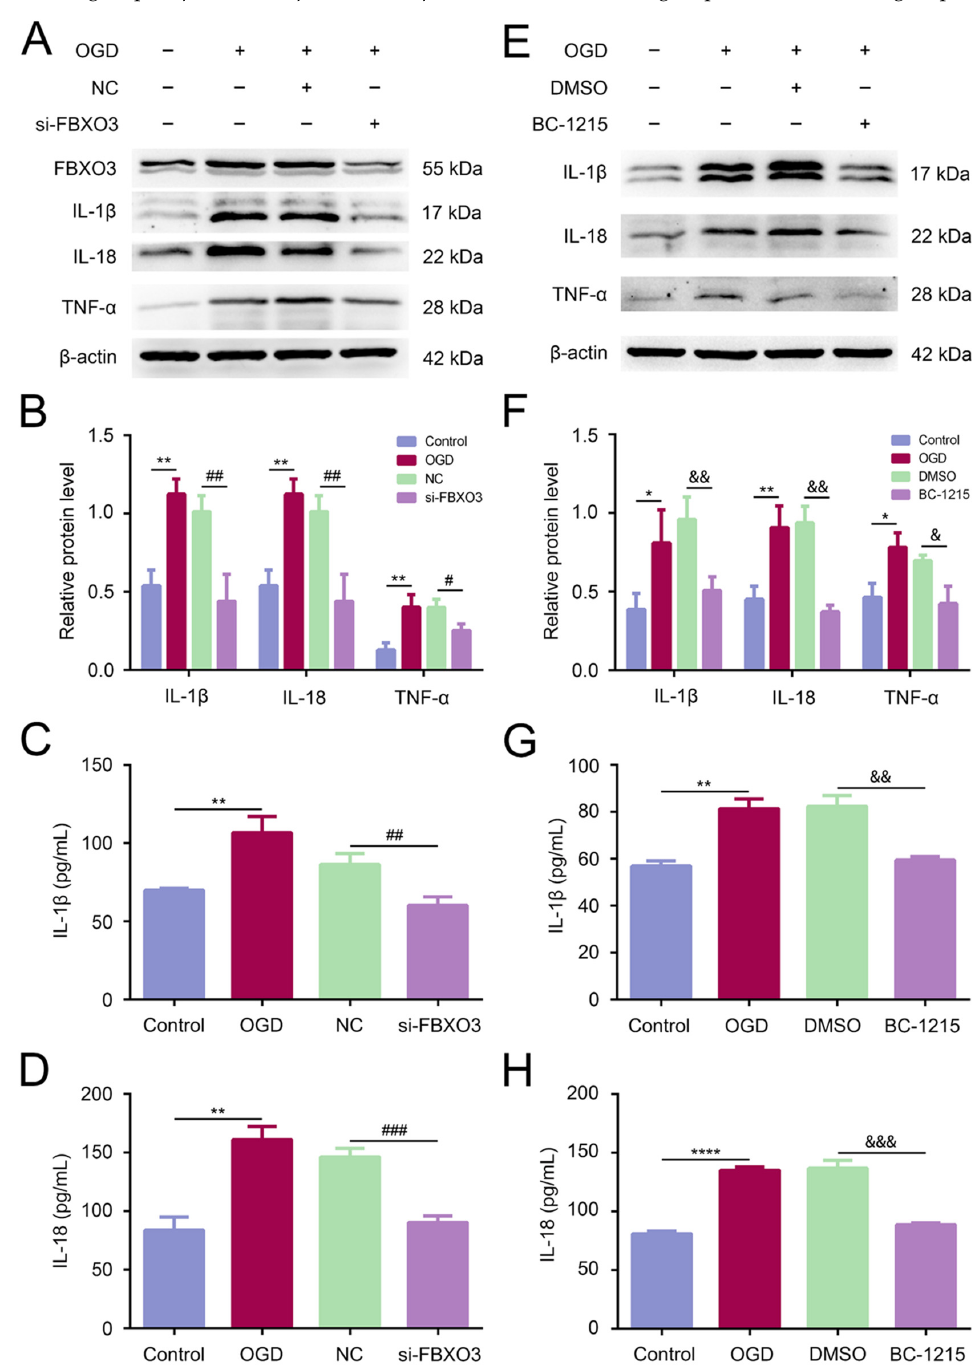
Figure 5. Inhibition of FBXO3 alleviated inflammatory response induced by I/R injury in vitro. ( A , B ) WB analysis of inflammatory cytokines including IL ‐ 1 β , IL ‐ 18, and TNF α in HT22 cells at OGD 4 h/R 24 h with or without siRNA treatment. ( C , D ) ELISA analysis of inflammatory cytokines